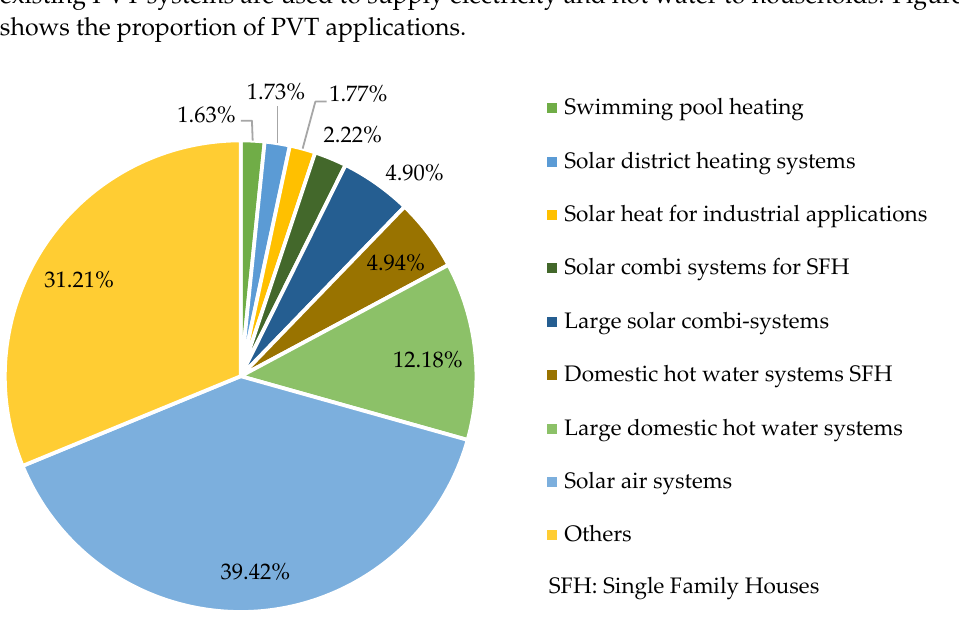
Figure 4. PVT systems utilization worldwide based on application. Data from ref. [76]. 2019. Weiss & Dür. Table 2. Various PVT products are available in the market.